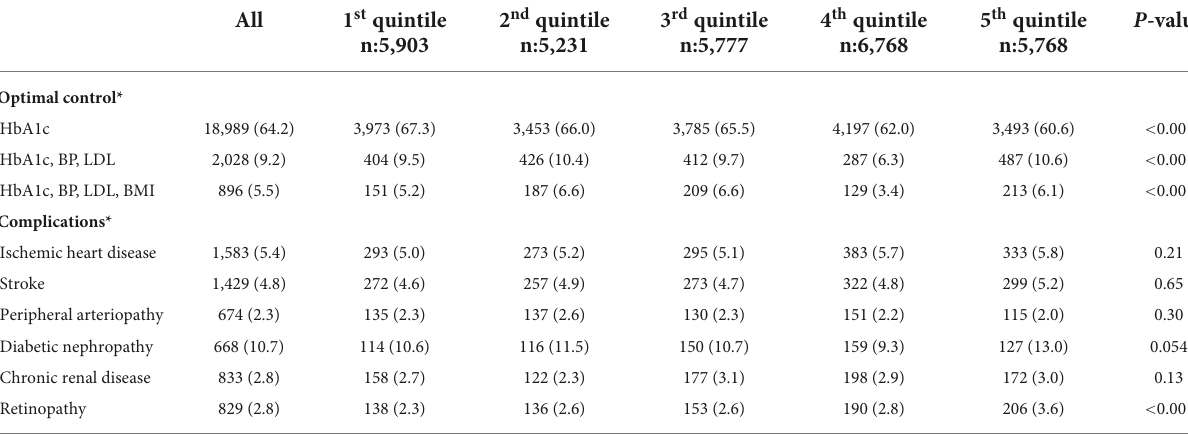
TABLE 3 Optimal control targets and complications in women based on a socioeconomic status index.